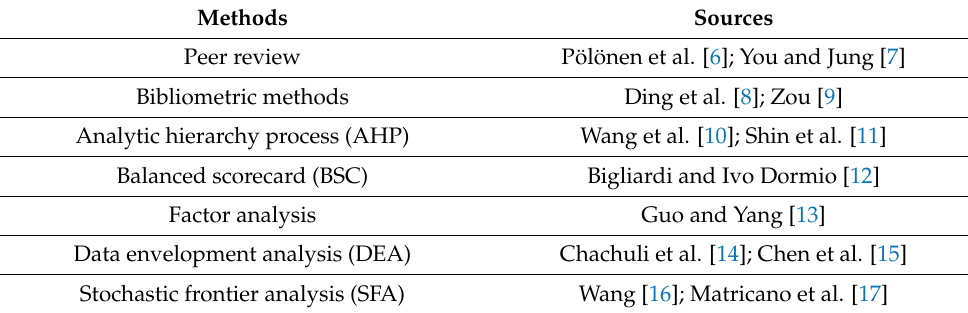
Table 1. Methods for the evaluation of R&D